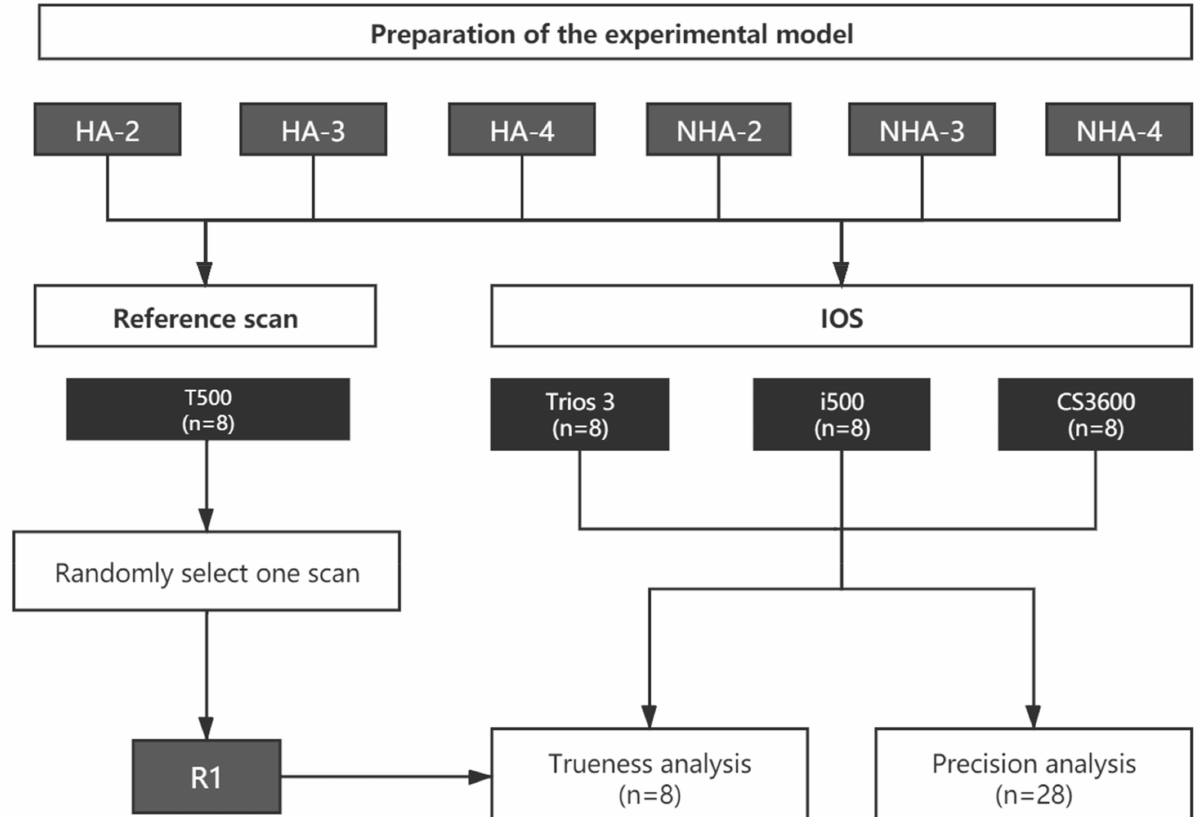
Figure 1. Workflow of the trueness and precision analysis for groups with healing abutment (HA). See the main text for the group definitions. R1 represents the most precise scan out of 28 scans after the precision